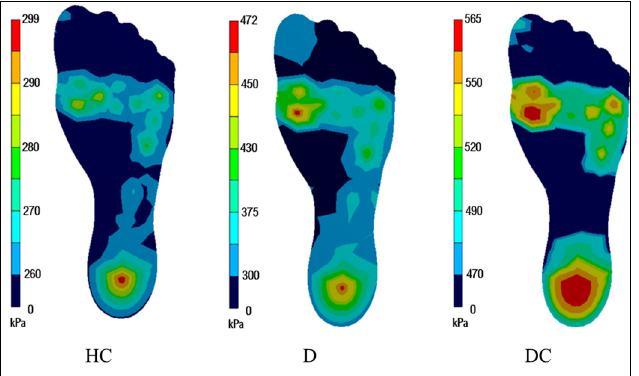
Figure 10. Plantar pressure distribution across the HC, D, and DC group.